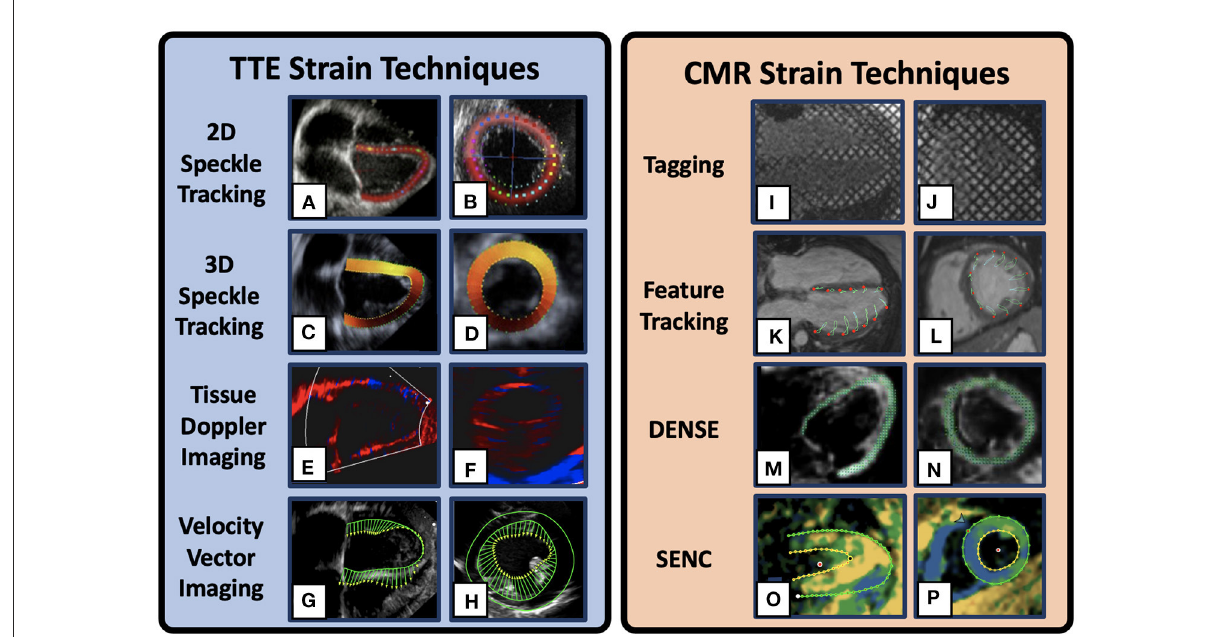
FIGURE1 Example Cardiac Strain Imaging Techniques. 2D speckle tracking Transthoracic echocardiogram (TTE) image in the 4-chamber (A) and mid-ventricular short-axis (B) [adapted from Mele et al. (33)]. 3D speckle tracking TTE images in the 4-chamber (C) and short-axis (D) [adapted from Maffessanti et al. (34)]. Tissue Doppler imaging TTE images in the 2-chamber long-axis (E) and short axis (F) in a DMD patient. Velocity vector TTE images in the 4-chamber (G) and short axis (H) in a DMD patient. Cardiovascular magnetic resonance (CMR) strain method depicting myocardial tagging in the 4-chamber (I) and mid-ventricular short-axis (J) views in a DMD patient. CMR feature tracking example images in the 4-chamber (K) and short axis (L) views. Displacement Encoding with Stimulated Echoes (DENSE) example images in the 4-chamber (M) and short-axis (N) views [adapted from Cao et al. (35)]. Strain Encoded example images in the 4-chamber (O) and short-axis (P) view plane in a DMD patient. Multiple visualizations are available for each technique and the images presented here are only